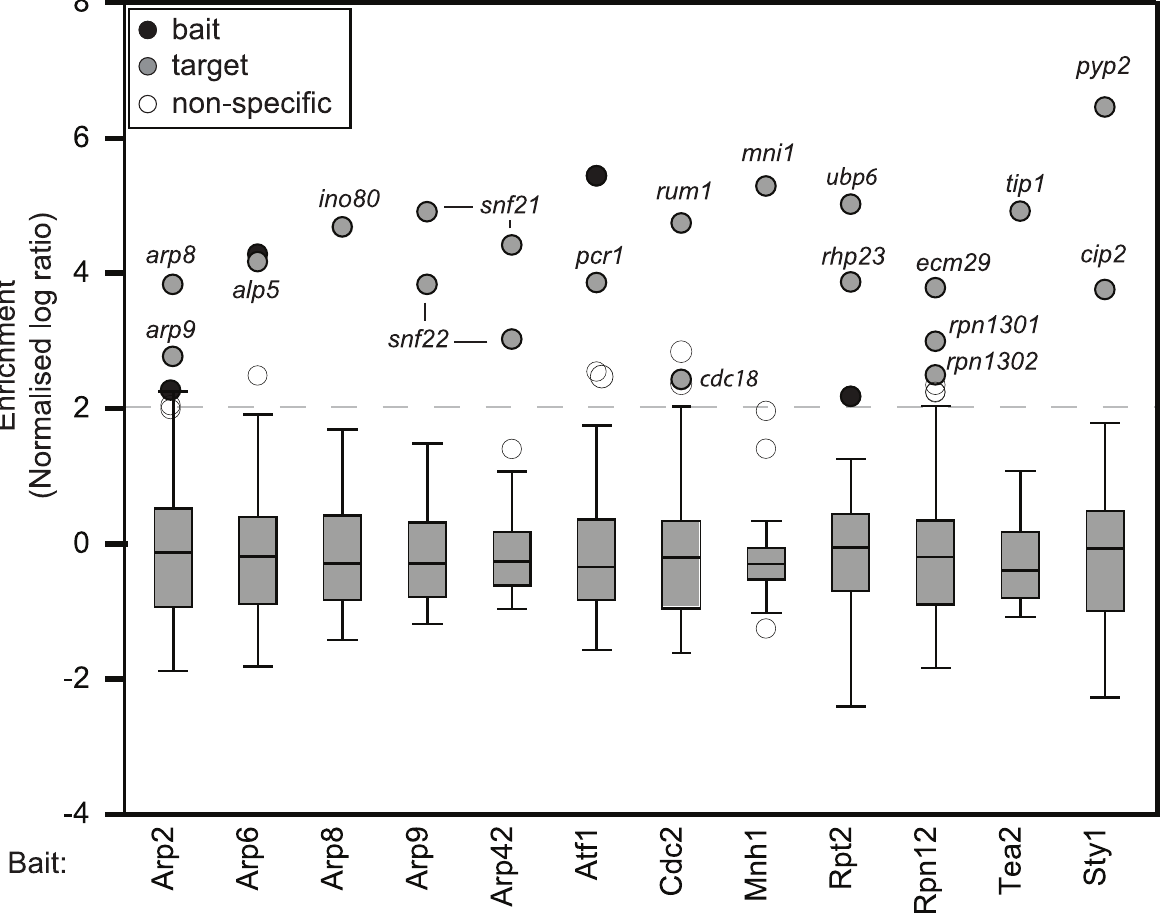
Figure 2. Many proteins that lack RNA–binding domains associate specifically with small numbers of mRNAs. Box plots of the distribution of enrichments for 12 RIp-chip experiments. The y axis shows normalised log 10 enrichment ratios in the corresponding RIp-chip experiments (see Figure 1 for details). For each protein, a representative experiment is presented. Black circles show the mRNA encoded by the bait protein used for the RIp-chip experiment, and grey circles other mRNAs that were consistently enriched in independent biological experiments. White circles represent mRNAs not considered significant, either because they are common contaminants in multiple RIp-chip experiments, or because they were not reproducibly enriched in independent replicas of the experiment. The dashed line at two standard deviations above the mean shows the threshold used to define mRNA enrichment.